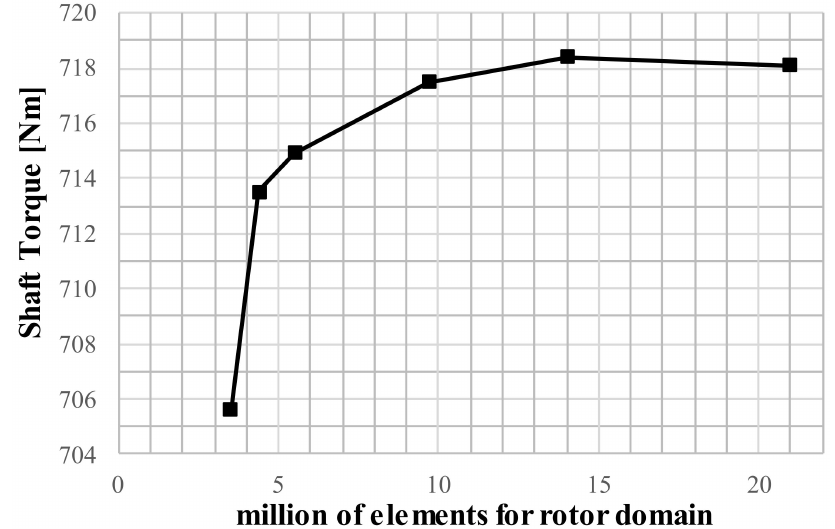
Figure 3. Shaft Torque versus number of elements of rotor domain.